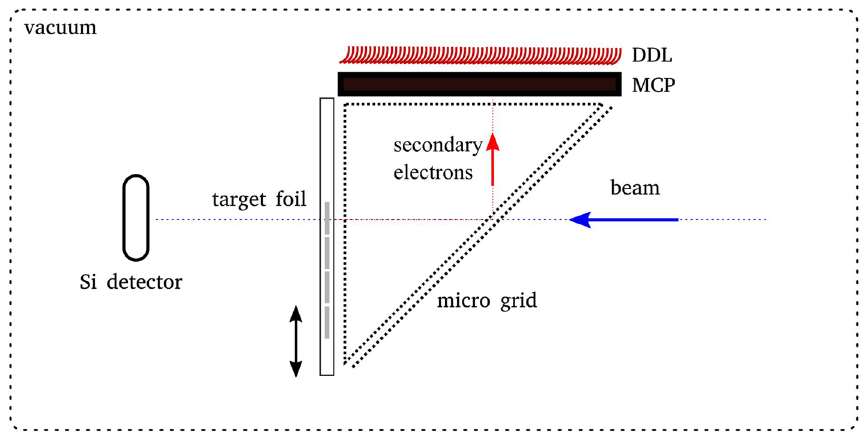
Figure 1. This figure shows a schematic of the experimental set-up for testing the SEE of thin material samples. Secondary electrons generated by ionizing radiation are detected with a micro-channel-plate (MCP) detector connected to a CFD1x from RoentDek for pulse height measurement. Secondary electrons are guided to the MCP via an electrostatic imaging system. Single ions are detected with an Si detector located behind the target.